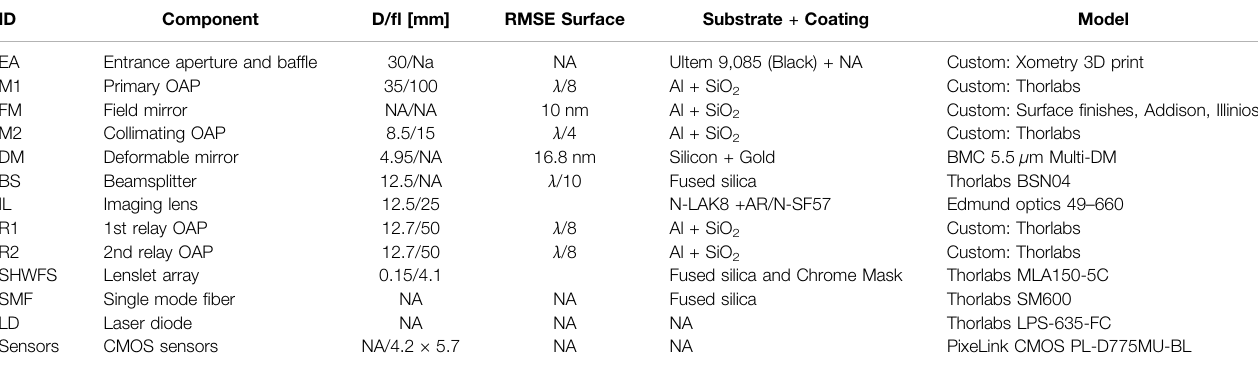
TABLE1| TableofOpticalComponents.Distheclearapertureofeachopticand fl istheeffectivefocallength.RMSEerrorsarespeci fi edinsurfaceunits.DMandFieldmirror surface errors are measured, others are manufacturer spec at λ (cid:2) 633 nm. NA specs are is not applicable to the part. ID